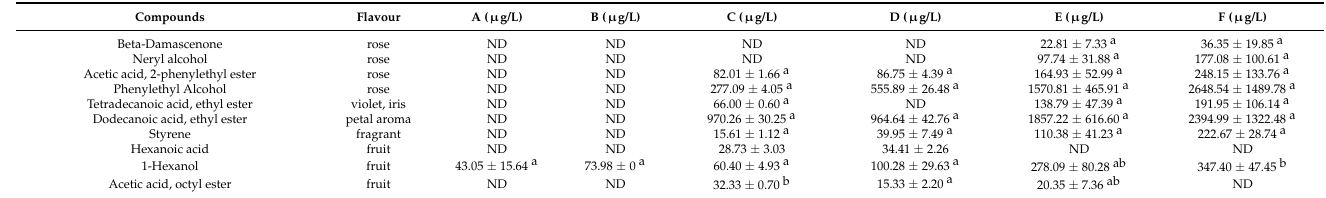
Table 3. Changes of flavor compounds during winemaking of Beimei red wine.